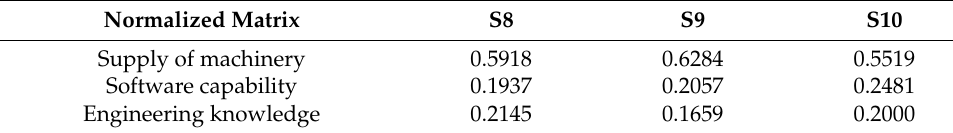
Table 9. The normalized matrix related to the technical indicators.